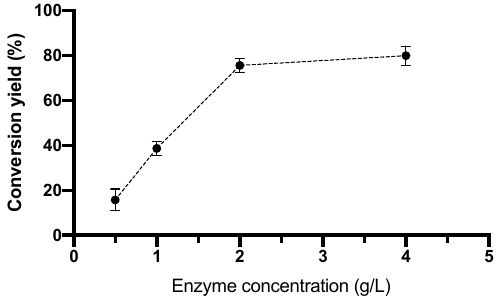
Figure 3. Effect of enzyme concentration on the conversion yield of UDCA-monoglyceride catalyzed by N435. All quantifications were performed in triplicate.